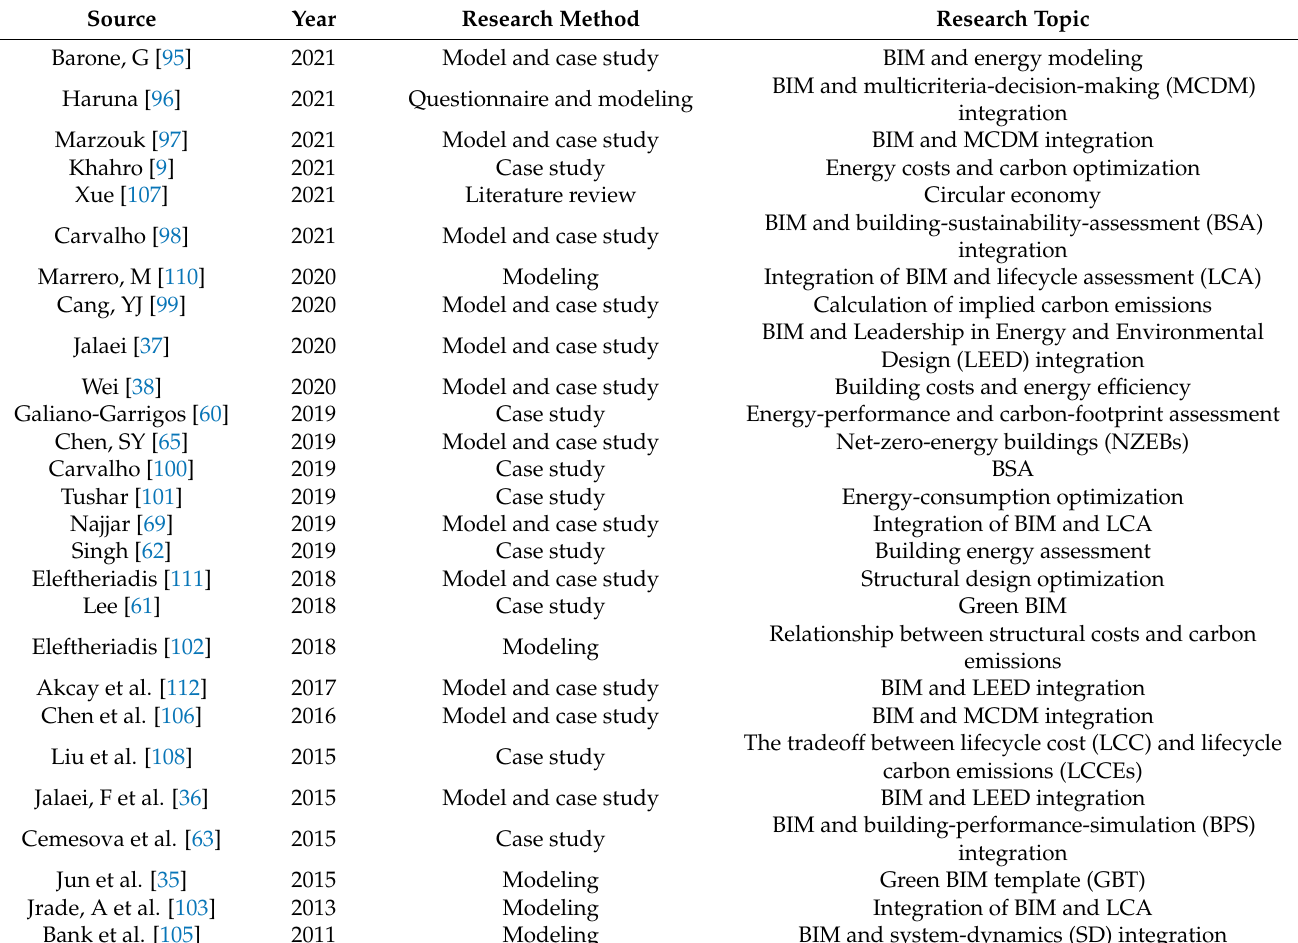
Table 2. The role of BIM in the building design stage in terms of carbon emissions (generated by the